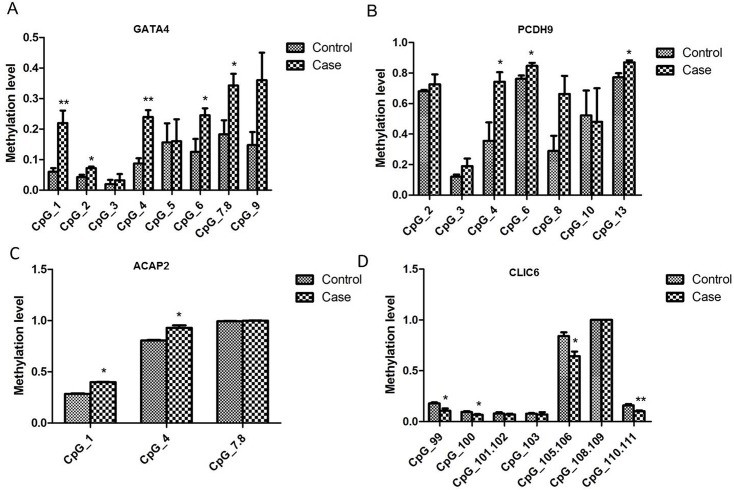
Validation of the methylation status of candidate DMRs between the late-onset severe PE group and the normal group by MassARRAY EpiTYPER.(A) The methylation level of the CpG sites within GATA4 amplicon. (B) The CpG methylation level sites within the PCDH9 amplicon. (C) The methylation level of the CpG sites within ACAP2 amplicon. (D) The CpG methylation sites within CLIC6 amplicon. Data are shown as the means±SEM, n = 20 per group, *p<0.05, **p<0.01. GATA4 amplicon: CpG_1, p = 0.0093; CpG_2, p = 0.0150; CpG_3, p = 0.5993; CpG_4, p = 0.0015; CpG_5, p = 0.9738; CpG_6, p = 0.0481; CpG_7.8, p = 0.0377; CpG_9, p = 0.0661.PCDH9 amplicon: CpG_2, p = 0.6177; CpG_3, p = 0.1831; CpG_4, p = 0.0294; CpG_6, p = 0.0265; CpG_8, p = 0.0529; CpG_10, p = 0.8818; CpG_13, p = 0.0158. ACAP2 amplicon: CpG_1, p = 0.0316; CpG_4, p = 0.0349; CpG_7.8, p = 0.3524. CLIC6 amplicon: CpG_99, p = 0.0446; CpG_100, p = 0.0424; CpG_101.102, p = 0.5504; CpG_103, p = 0.7697; CpG_105.106, p = 0.0310; CpG_108.109, p = 1.0000; CpG_110.111, p = 0.0084.